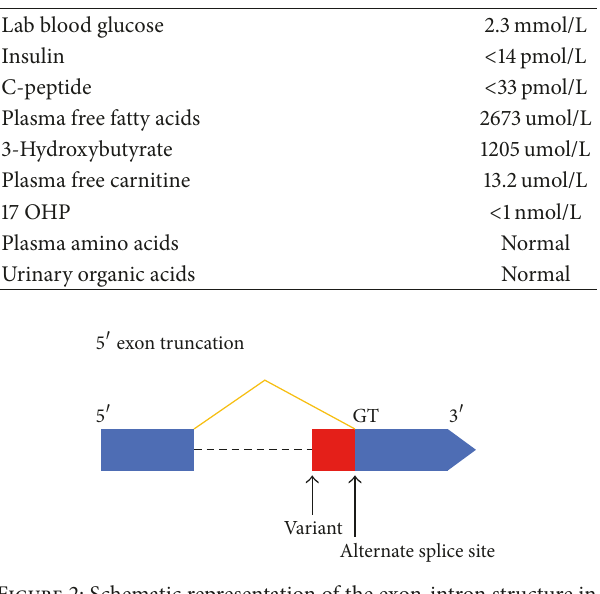
Table 2: Results of investigations following a 19-hour fast.